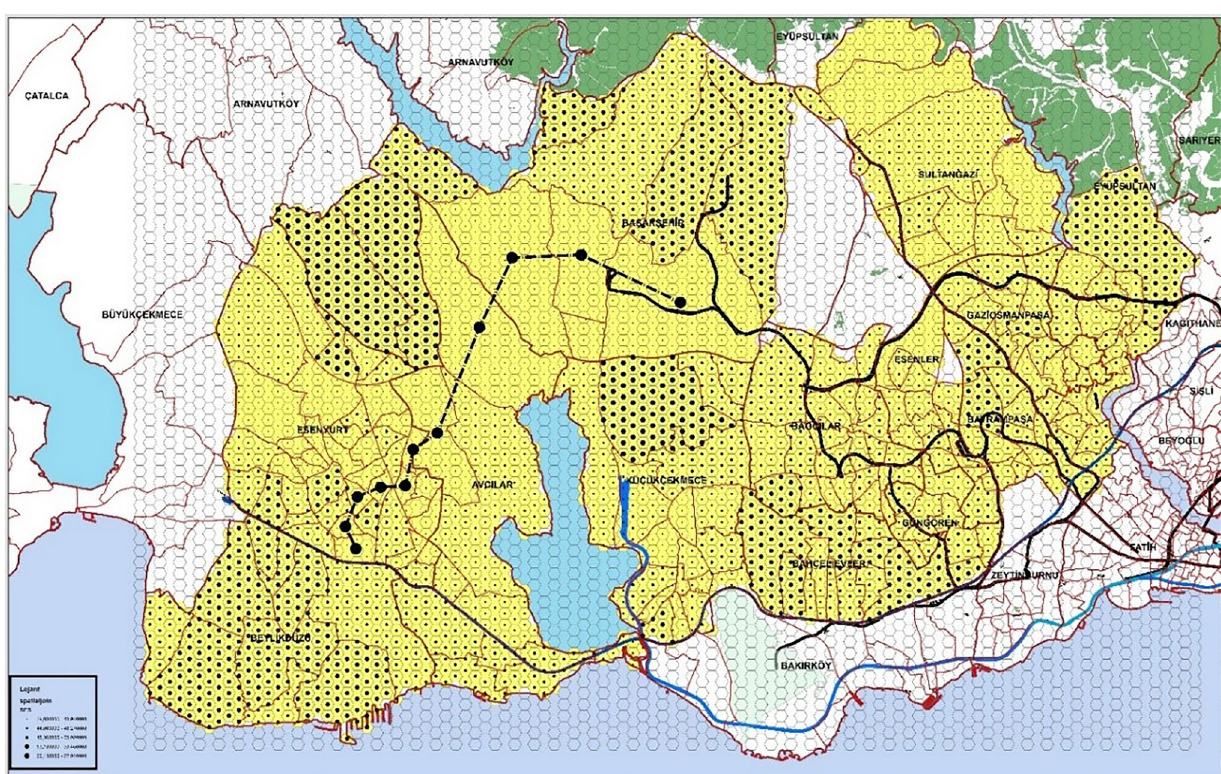
Fig. 1 Socio-economic status values (illustrated by